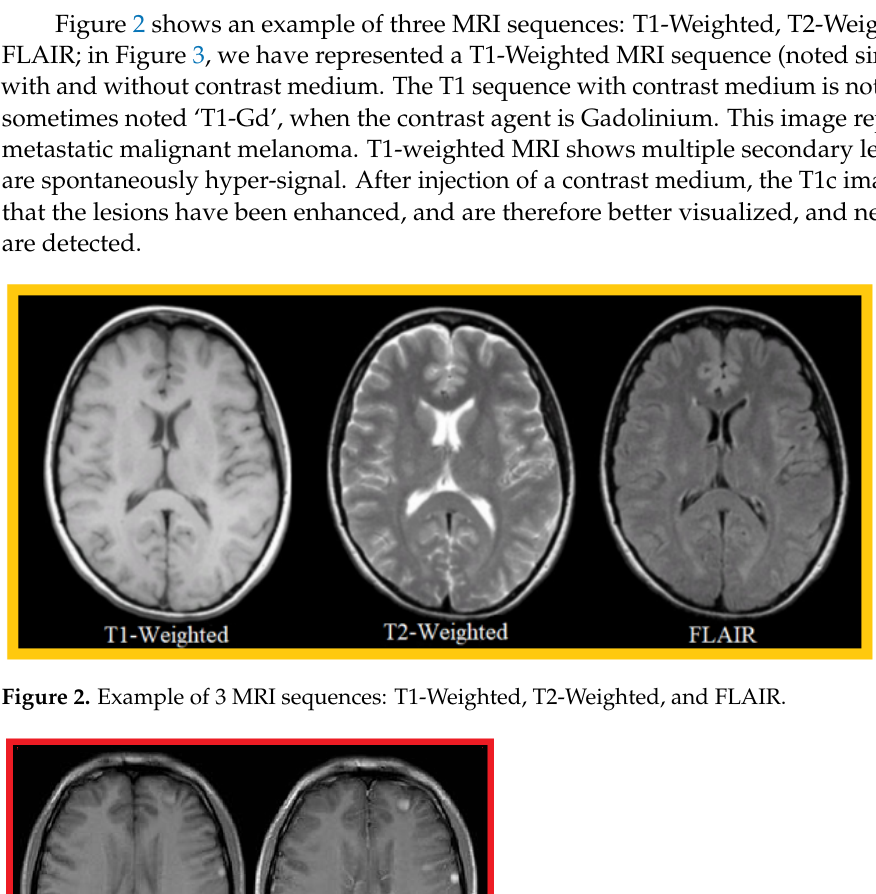
Figure 1. ( A ) MRI of the brain: axial FLAIR section. A thin ‐ walled cyst ‐ like image (arrow) consistent with an ependymal cyst can be seen in the occipital extension of the left lateral ventricle. ( B ) Brain cross ‐ section (illustration).